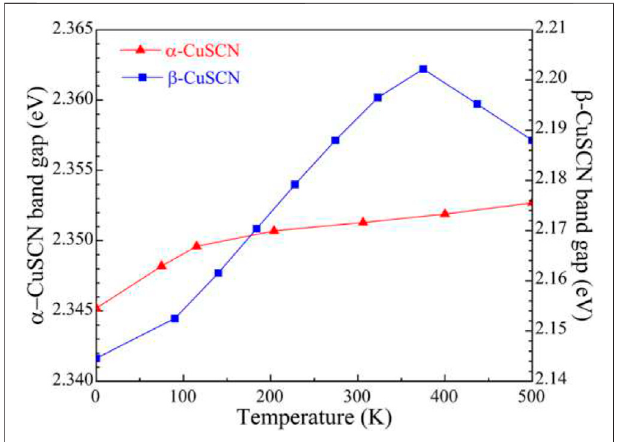
FIGURE 7 | Thermal expansion – induced changes of the bandgaps in the α - and β -CuSCN.